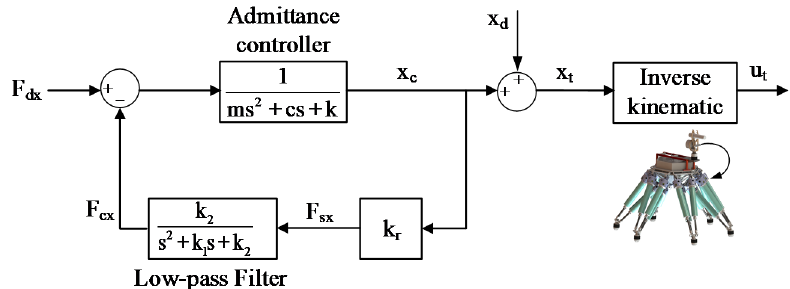
Figure 12. The robot admittance control system.